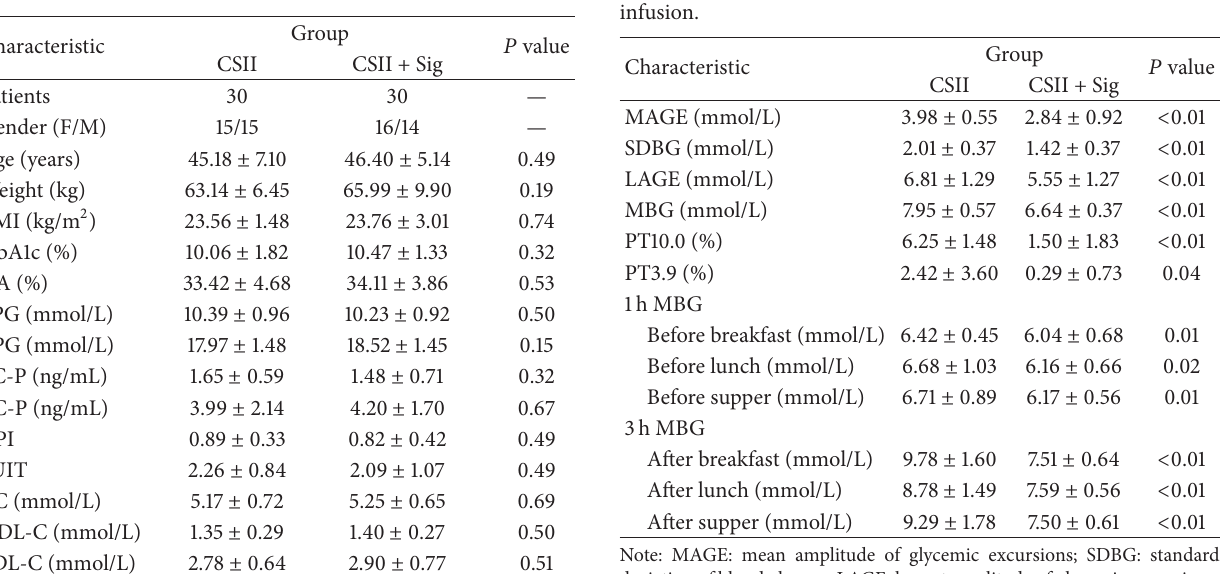
Table 1: Baseline comparisons between the CSII and CSII + Sig groups before treatment.